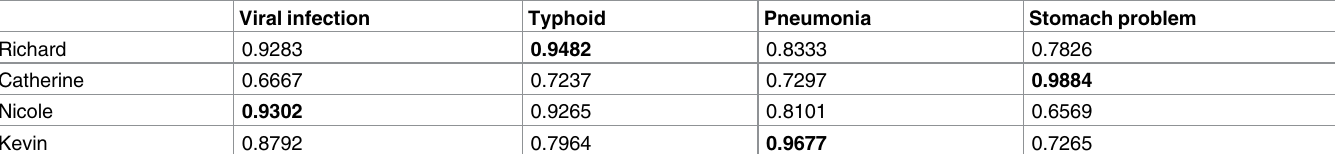
ð H 1 ; H 2 Þ between each patient’s symptoms and possible HFLTSs s s